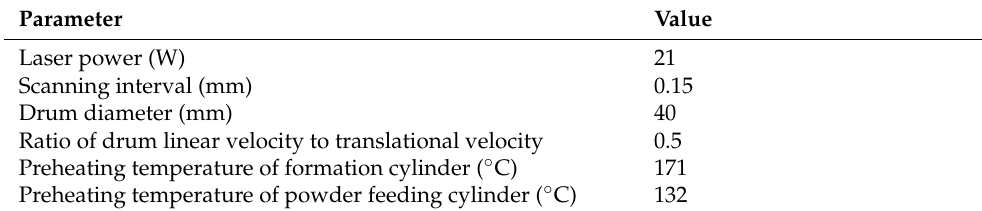
Table 6. SLS process parameters used in the experiment.